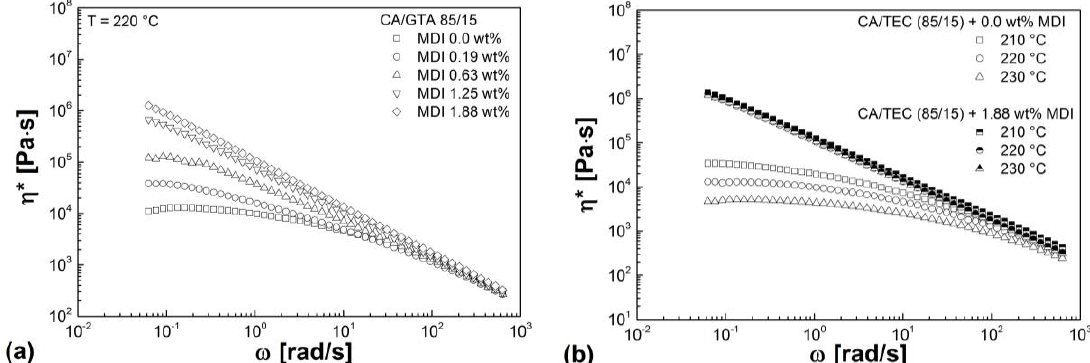
Figure 10. ( a ) Complex viscosity of CA/TEC/MDI as a function of radial frequency in dependence of MDI content. ( b ) Complex viscosity of CA/TEC (85/15) in comparison to CA/TEC (85/15) with 1.88 wt% MDI as a function of radial frequency in dependence of